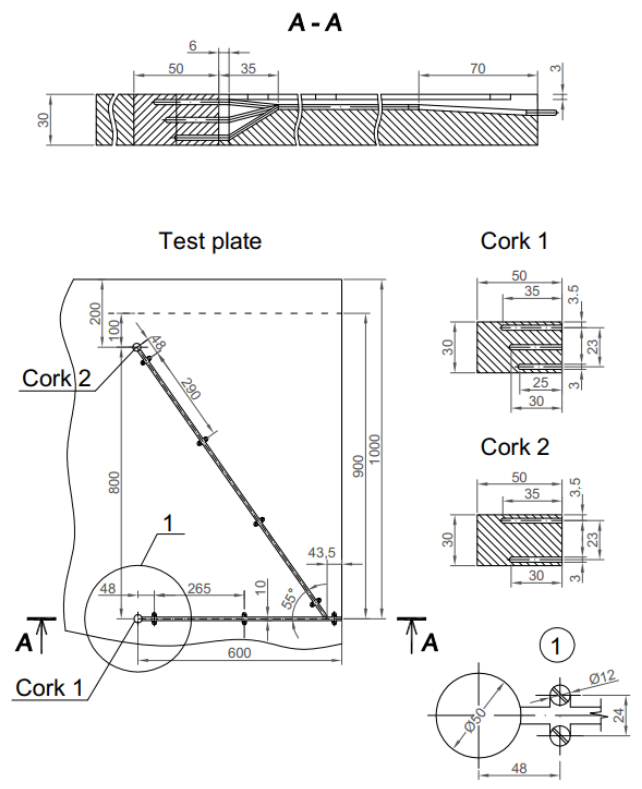
Figure 11. Schematic of the measuring complex.